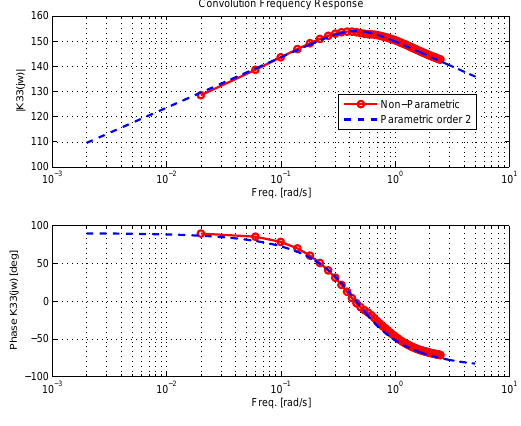
Figure 8: Reconstruction of potential damping from the real part of ˆ K 33 ( jω ) based on Realiza- tion theory.